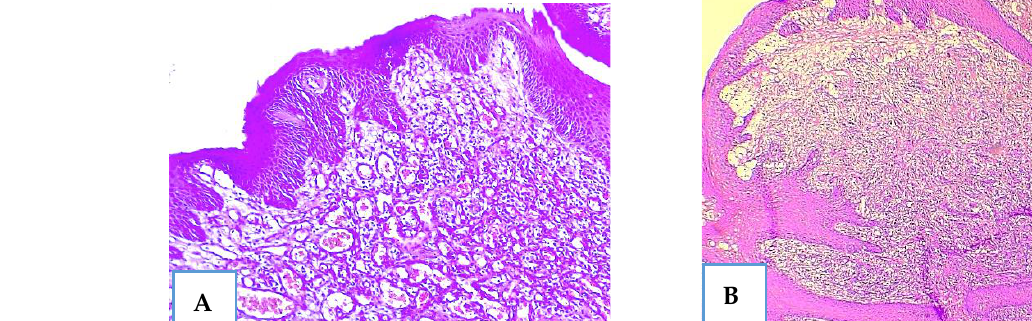
A Figure (4-A): Photomicrograph non-lobular PG 10x